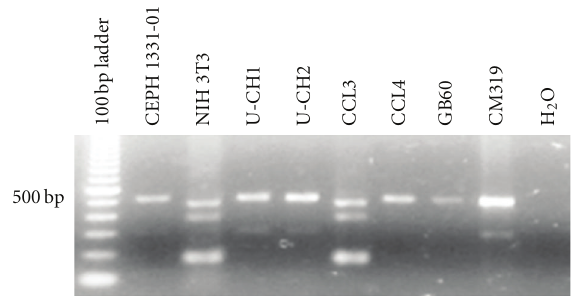
Figure 6: Species analysis of putative chordoma cell lines. Agarose gel electrophoresis of ethidium-stained DNA of aldolase PCR analysis of genomic DNA reveals murine origin for CCL3 as shown by similar amplicon fragment sizes found in the murine cell line, NIH 3T3, as compared to those generated from the normal humangenomicsample,CEPH 1331-01. The other cell lines (CCL4, CM319, GB60, U-CH1, and U-CH2) gave similar amplicon sizes as those for the human control genomic sample CEPH